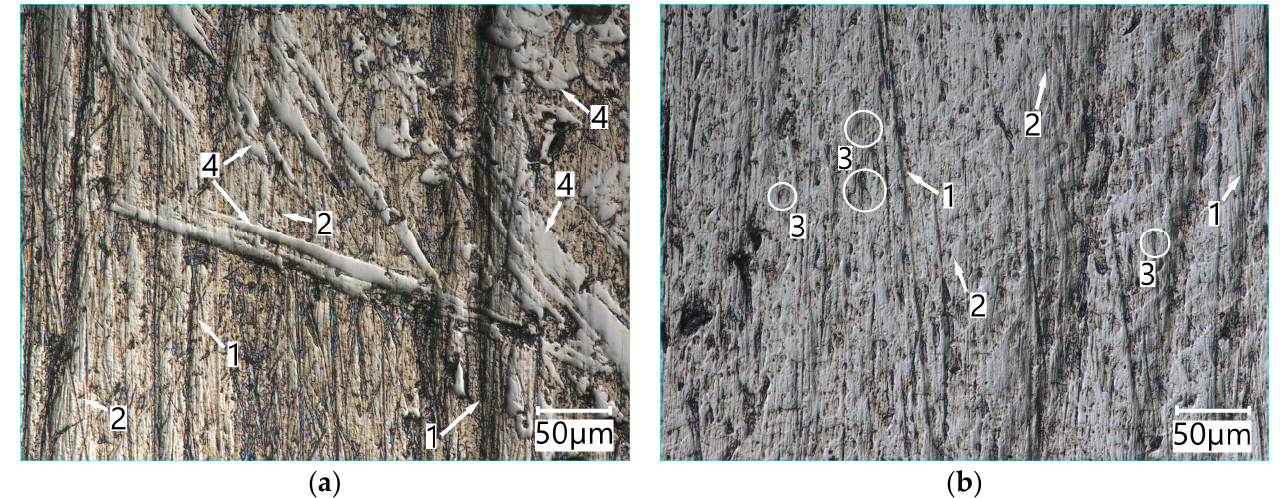
Figure 12. The surface of PMFe60P padding weld worn in the medium soil ( a ) and light soil ( b ): 1 — ploughing, 2 —micro-cutting, 3 —areas of material loss, 4 —carbide precipitates. Optical light microscopy. The surface of PMFe60P padding weld worn in the light soil shows shallow scratches resulting from ploughing and small traces of micro-cutting (Figure 12b). In addition, losses of the matrix material can be noted in the form of shallow oval depressions. The view of the surface suggests that the impact of loose abrasive grains resulted in the softer matrix phase being removed most intensively (Figure